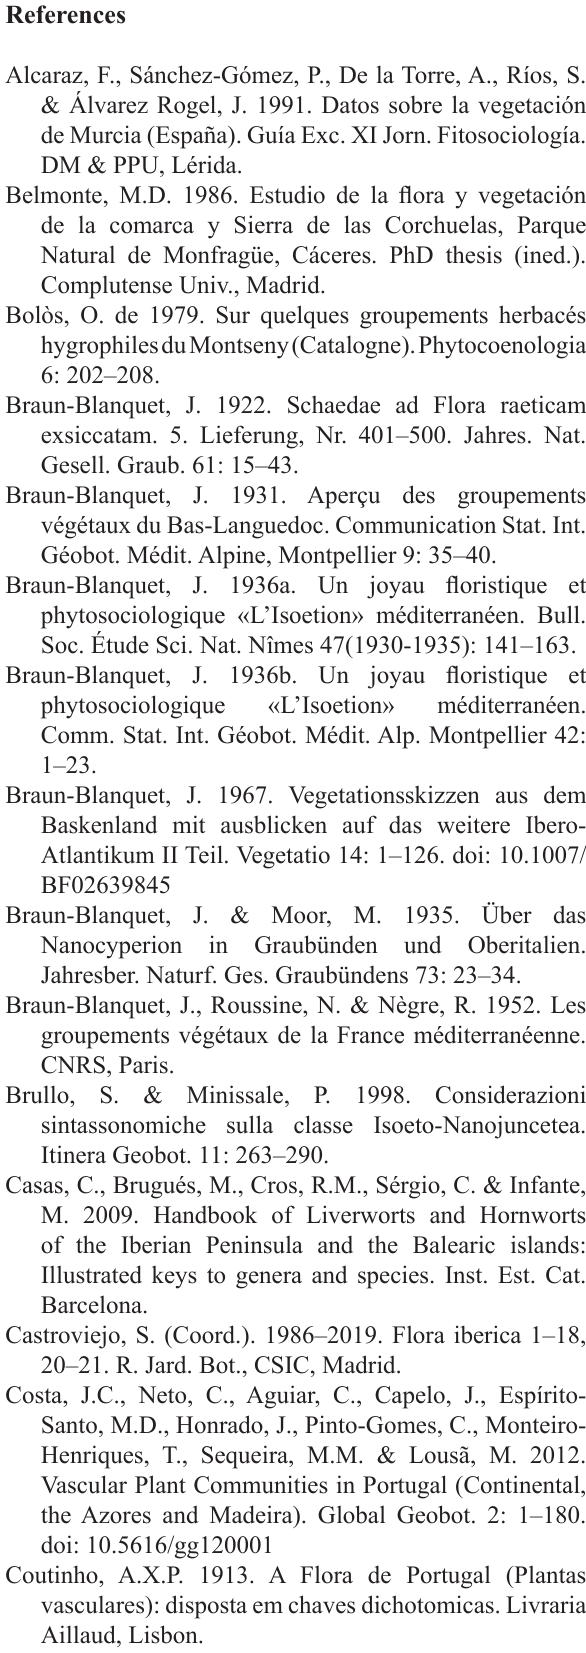
Table 14, rel. 6: Laguna de Ontígola, Aranjuez, Madrid, 30TVK43,